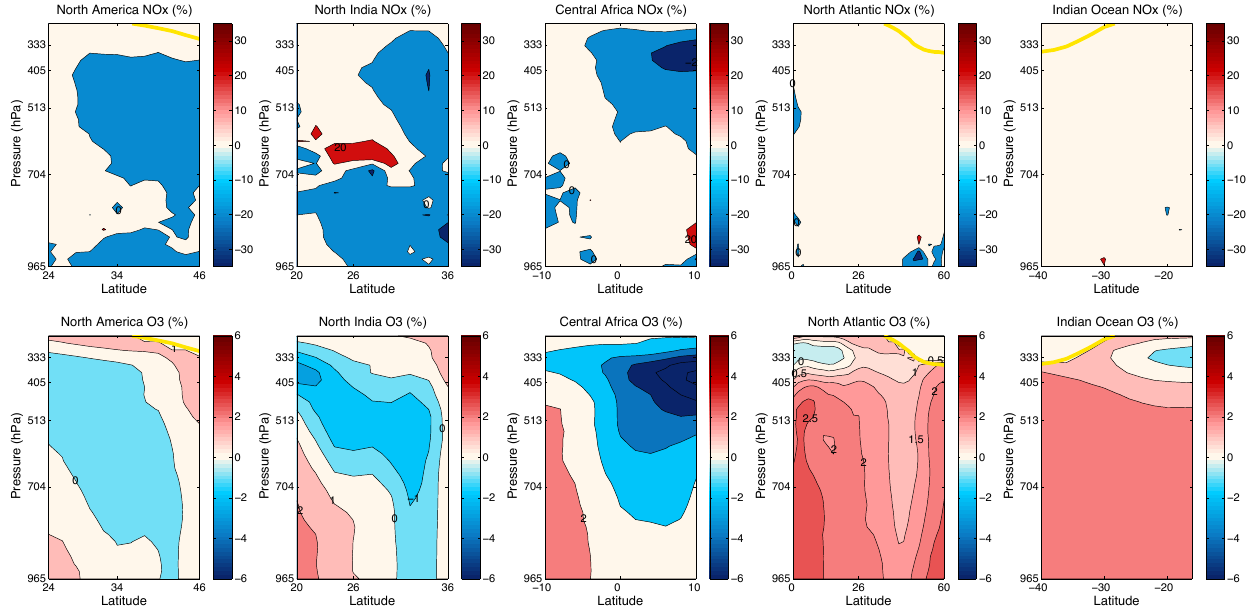
Figure 7. Zonal averaged NO x (upper panels) and O 3 (bottom panels) variations (in %) over the regions characterized by strong NO x emissions for July (the yellow solid line represents the tropopause level) from the relative difference between P1 and BC experiments (P3/BC). P1 was performed using τ and K eff determined with D h = 15m 2 s − 1 and NO mean